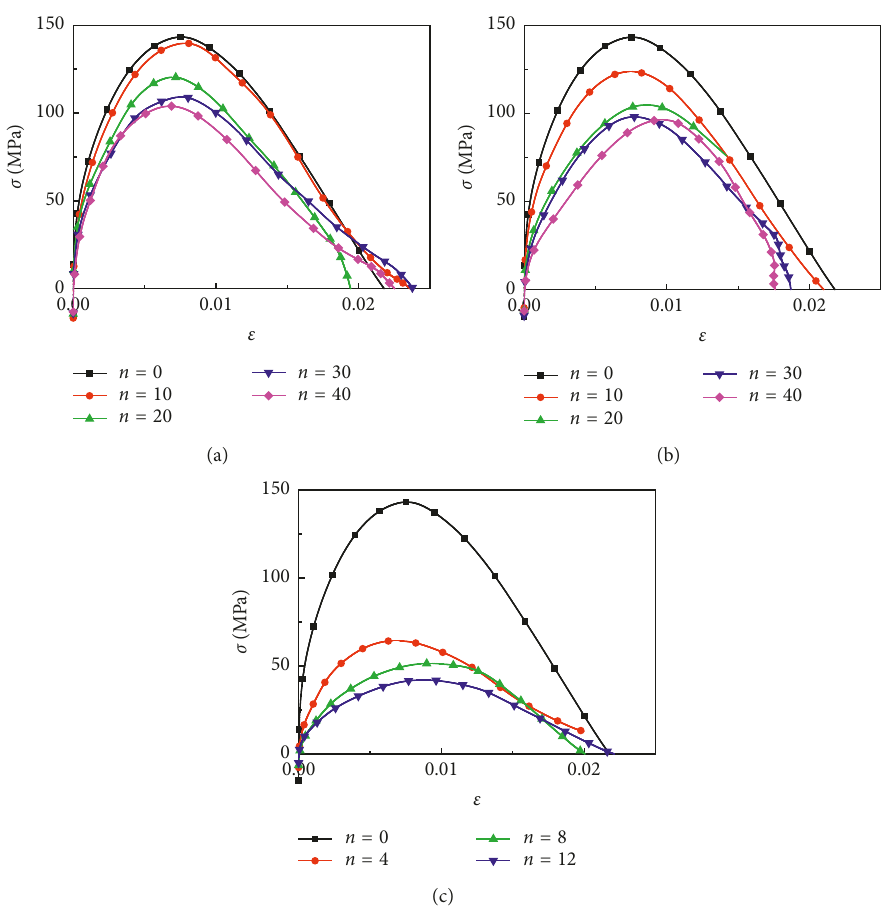
Figure 8: Dynamic stress-strain curve of sandstone specimens after H-C cycles: (a) L-T group, (b) M-T group, and (c) H-T group.